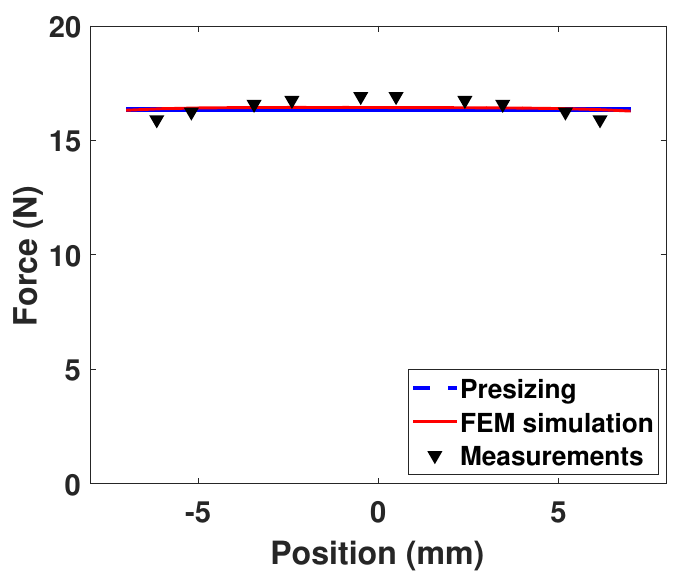
Figure 16. Force-position relation, for a constant input current.